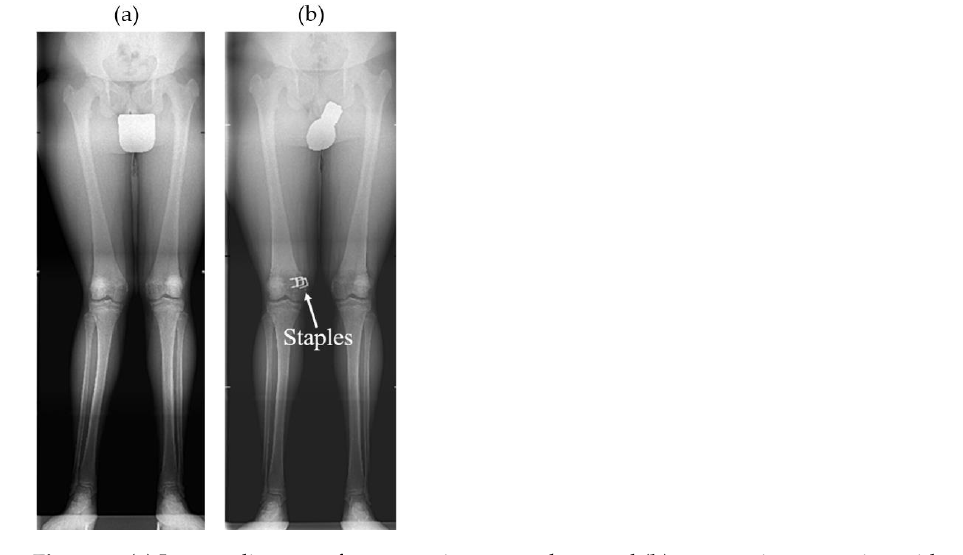
Figure 1. Parts of the growing bone (tibia).